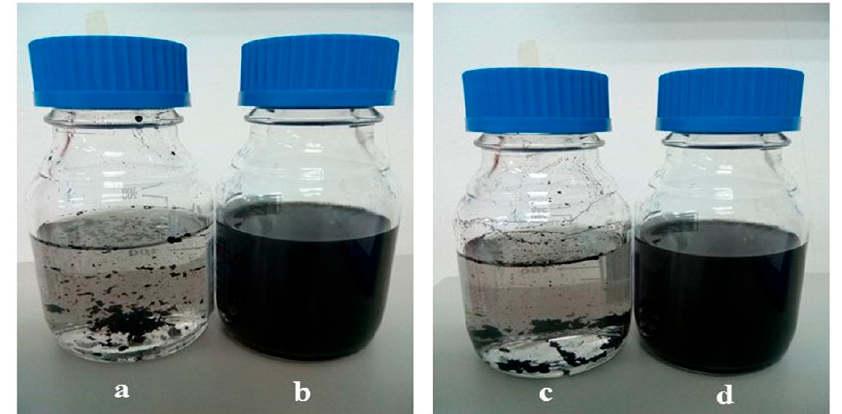
Figure 3. Carbon nanotubes suspension ( a ) sonication of multi-walled carbon nanotubes (MWCNTs) in distilled water (DW), ( b ) sonication of MWCNTs in surfactant (SDBS), ( c ) sonication of double-walled carbon nanotubes (DWCNTs) in DW, and ( d ) sonication of DWCNTs in surfactant (SDBS) for 30